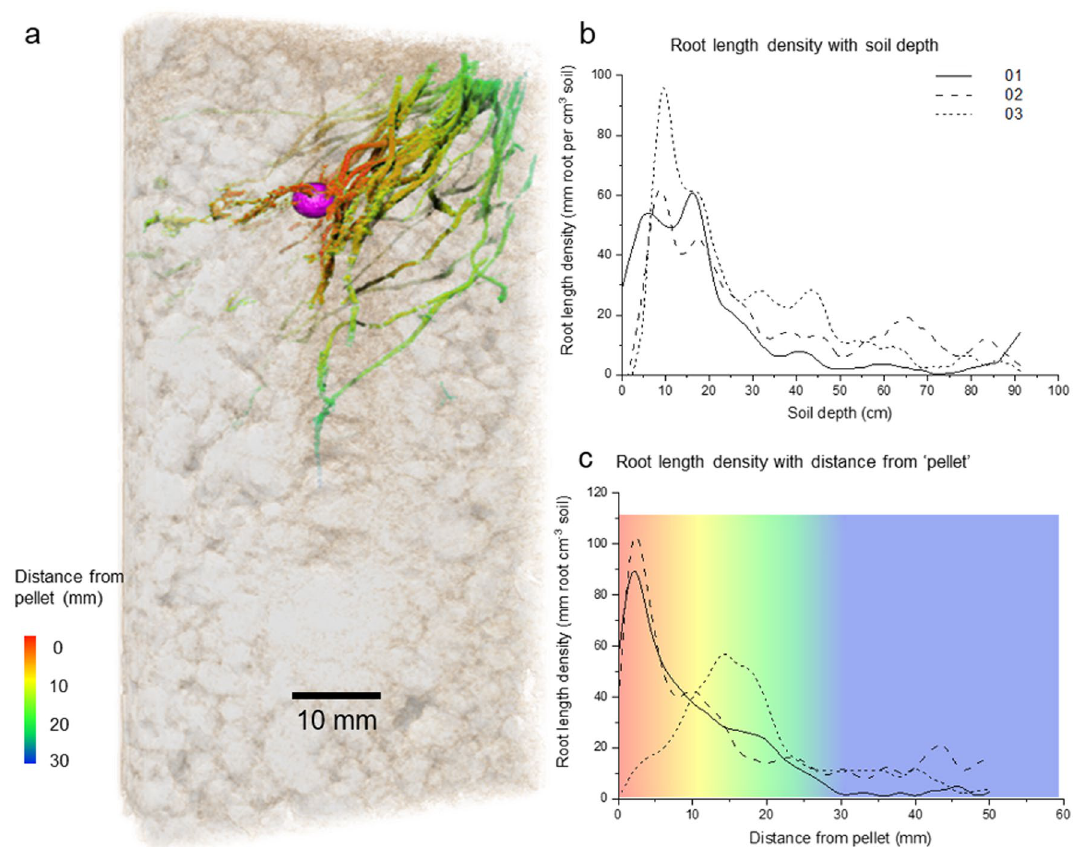
is rendered in purple and the root are coloured by their distance from the fertiliser pellet. ( b ) Root length per depth. ( c ) Root length density with distance from estimated positions of fertiliser pellets (distances are